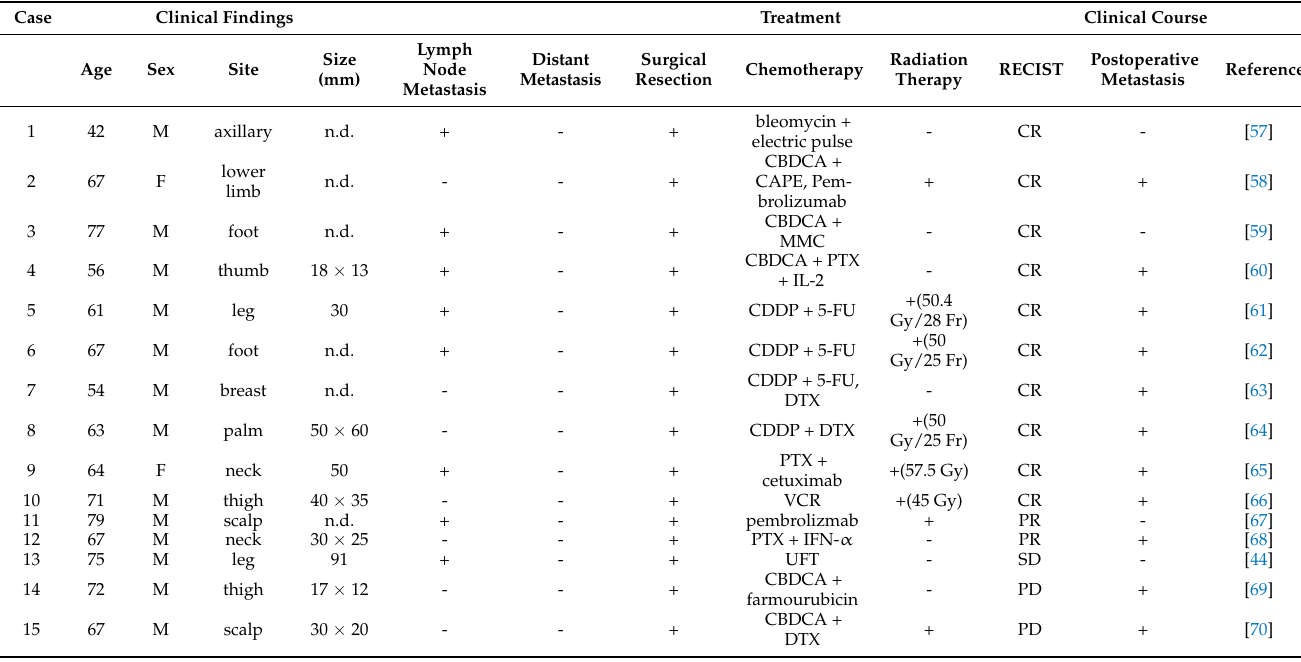
Table 1. A summary of 28 cases treated with systemic